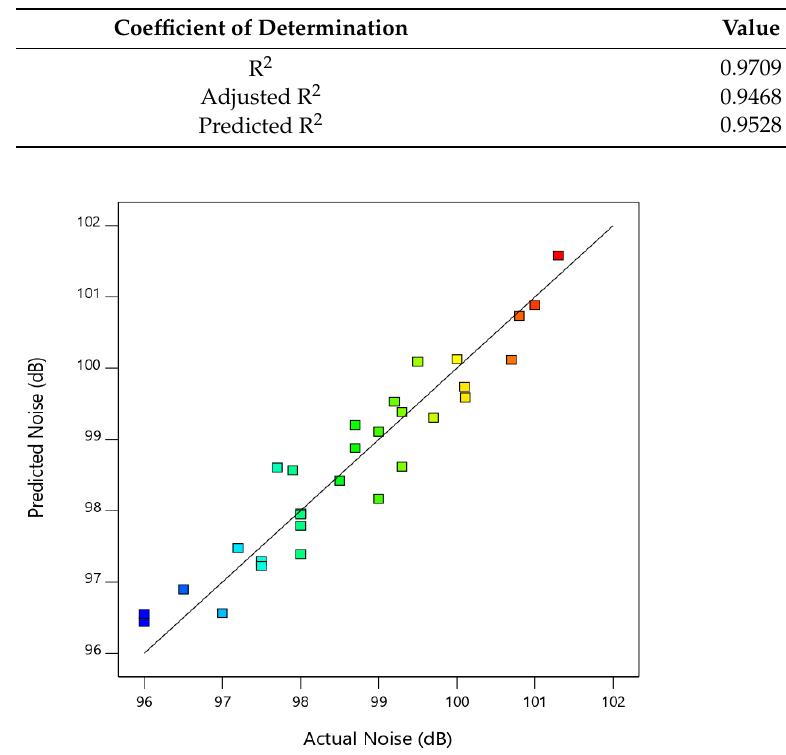
Table 13. Coefficient of determination for noise.